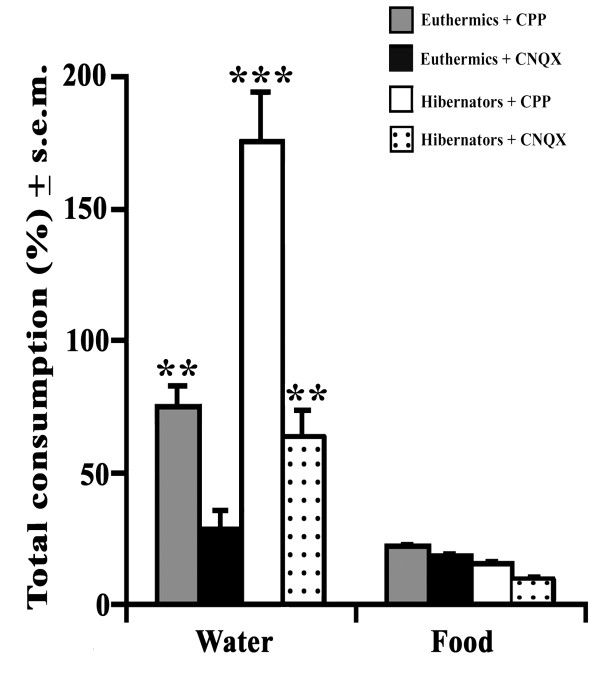
Glutamatergic effects on feeding and drinking behaviors of euthermic and hibernating hamsters. Glutamatergic-dependent activities were induced by locally administering most effective concentrations of NMDA (CPP; 7.93 nM, grey and white squares) and AMPA antagonists (CNQX; 36.2 nM, black and dotted squares) into BLA of both euthermic (grey and black squares) and hibernating (white and dotted squares) adult Syrian golden hamsters (n = 16) with respect to NMDAR and AMPAR controls (n = 8) using stereotaxic methods. Total feeding (g) and drinking volume (ml) percentages (mean ± s.e.m.) were calculated with respect to controls that only received a saline solution. Data were analyzed by two-way ANOVA followed by Newman-Keuls post-hoc test when a p-value ≤ 0.05. *p < 0.05; **p < 0.01; ***p < 0.001. Comparisons were handled on both the two physiological states and treatment groups that are numerically indicated above histograms.